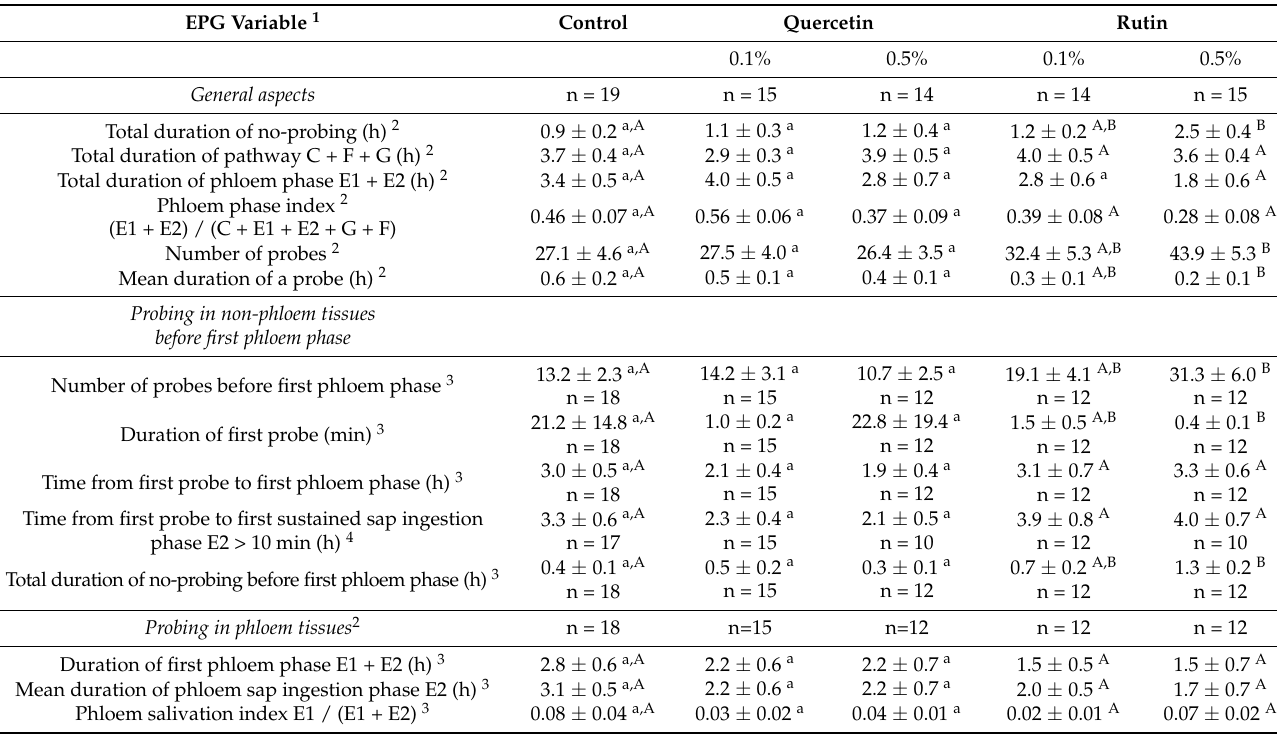
Table 2. EPG-recorded stylet penetration activities of Myzus persicae on Brassica rapa subsp. pekinensis treated with 0.1% and 0.5% ethanolic solutions of quercetin and